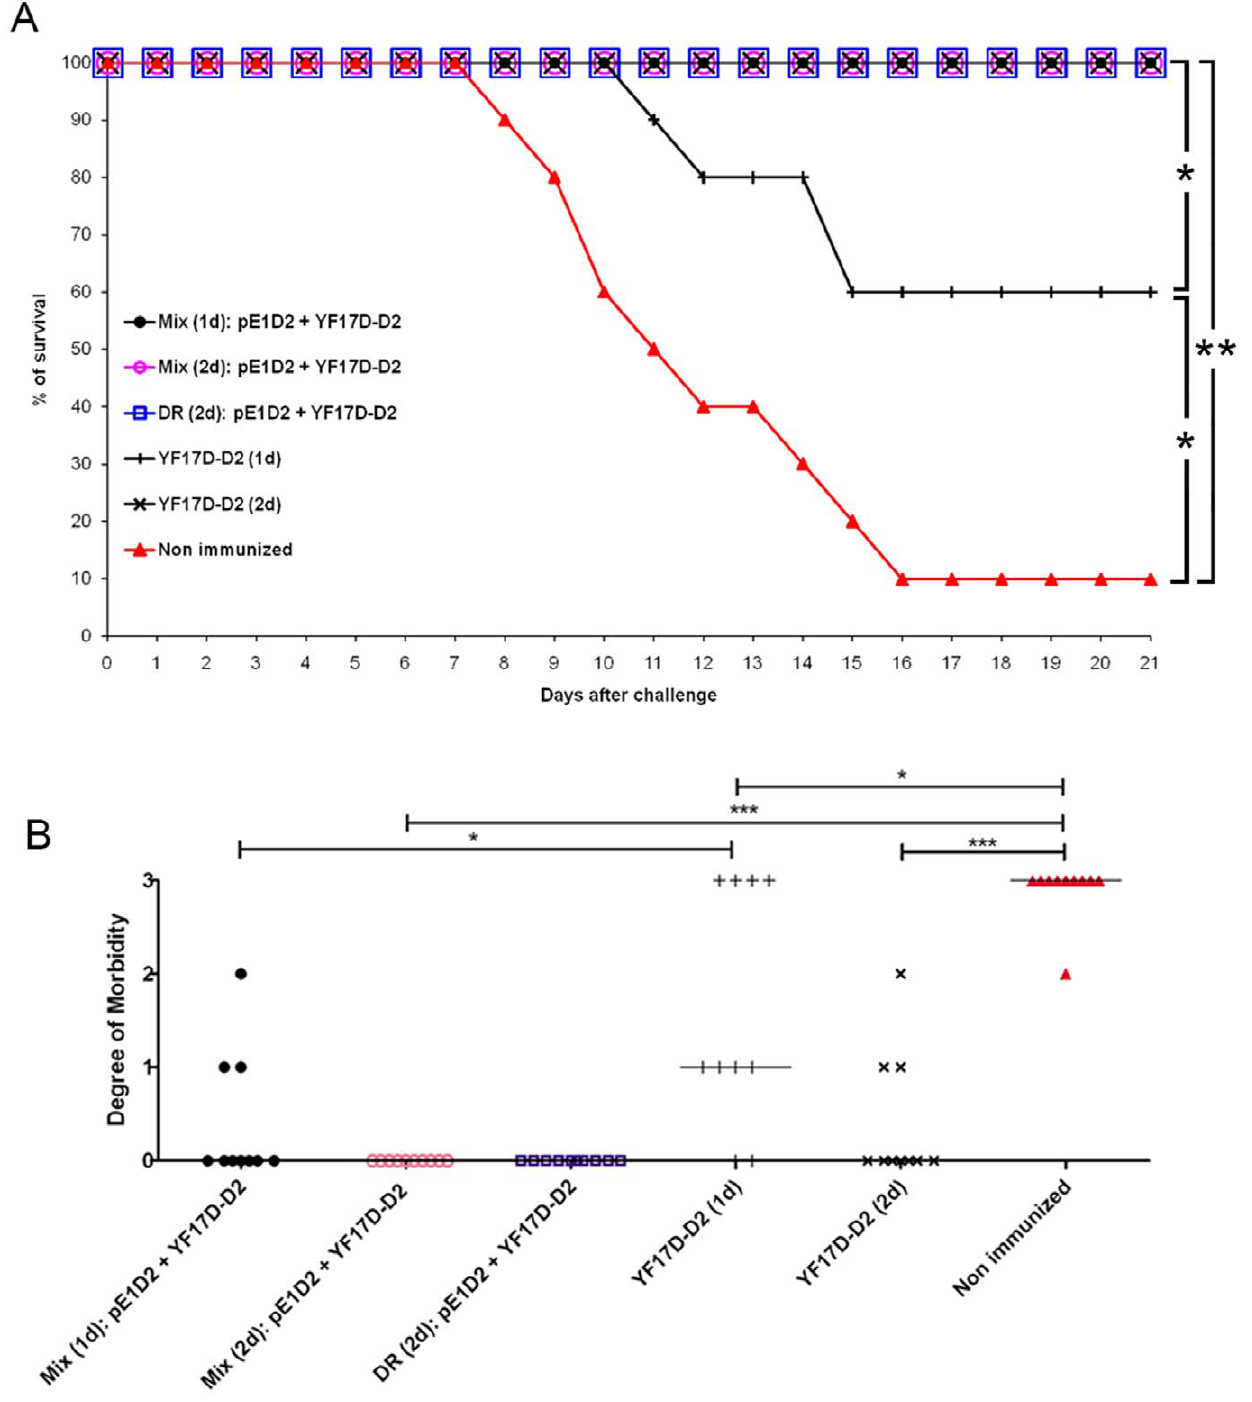
Figure 4. The protective efficacy of vaccination with pE1D2 and YF17D-D2 against DENV2 inoculated simultaneously. Groups of Balb/c mice (n=10) were immunized by the i.m. route with a mixture of these two vaccines (Mix) or by the i.m. inoculation of the pE1D2 plasmid and s.c. administration of the YF17D-D2 chimeric virus simultaneously (different routes, DR). Animals were challenged (i.c.) with the NGC DENV2 and monitored for 21 days after challenge with the record of survival rates (A) and degree of morbidity (B). Asterisks indicate statistically significant differences using the chi-square test in (A) (*p , 0.001; **p , 0.0001) and the Mann-Whitney test in (B) (*p , 0.05; **p , 0.01, ***p , 0.001). One dose=1d; two doses=2d. doi:10.1371/journal.pone.0058357.g004 more protective than each vaccine administered singly, specially These animals were fully protected, without presenting any clinical when two doses of the DNA vaccine pE1D2 were administered. sign of the dengue infection, either in mouse groups submitted to